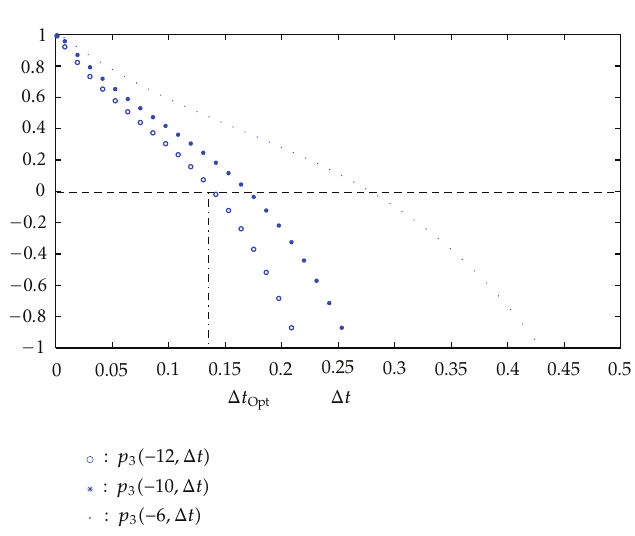
Figure 1: Graphs for p 3 (cid:9) a, Δ t (cid:10) where a (cid:6) − 6: · , a (cid:6) − 10: ∗ , a (cid:6) − 12: ◦